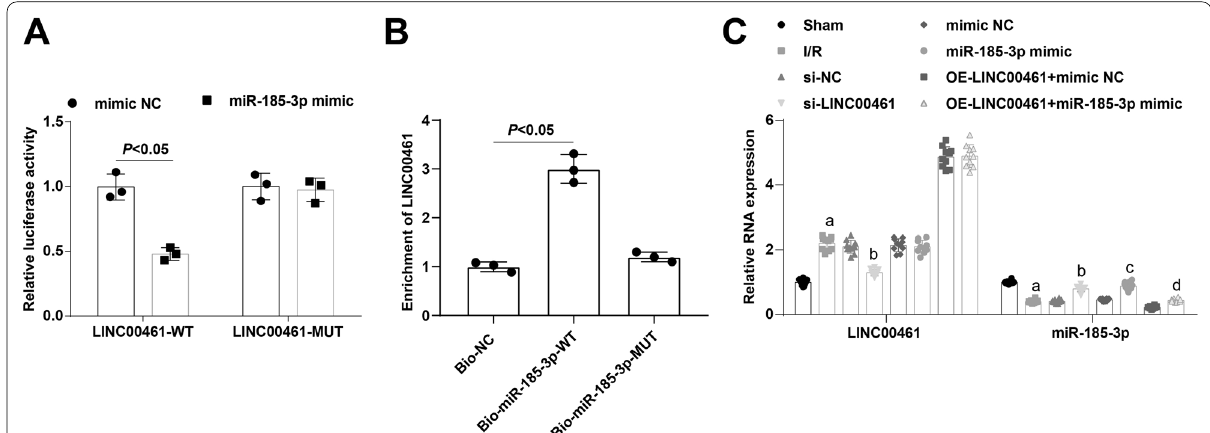
Fig. 1 LINC00461 binds to miR-185-3p; LINC00461 is up-regulated while miR-185-3p is down-regulated in I/R mice. A Dual luciferase reporter gene assay verified the regulatory relationship between LINC00461 and miR-185-3p. B The relationship between LINC00461 and miR-185-3p in myocardial tissue by RNA-pull down assay. C Expression of LINC00461 and miR-185-3p in myocardial tissue of mice in each group. a P < 0.05 vs. the sham group. b P < 0.05 vs. the si-NC group. c P < 0.05 vs. the mimic-NC group. d P < 0.05 vs. the